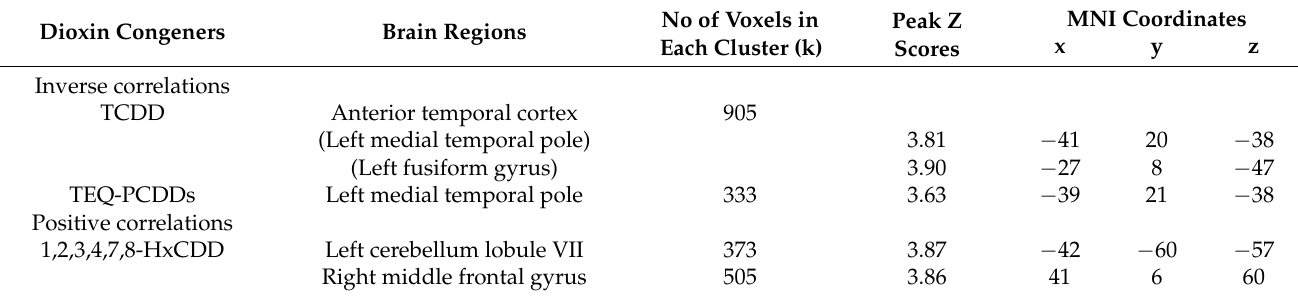
Table 3. Brain regions significantly correlated with blood levels of dioxin congeners in men after adjusting for total intracranial volume and age (FDR-corrected at p <